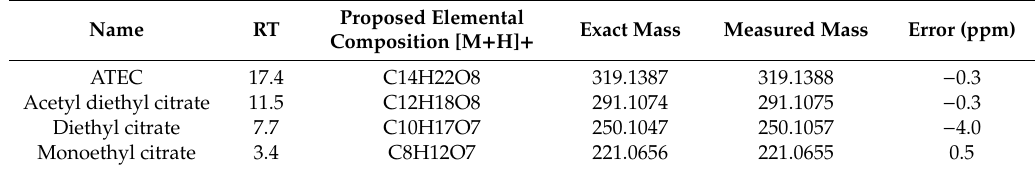
Table 4. Accurate mass data for ATEC and its